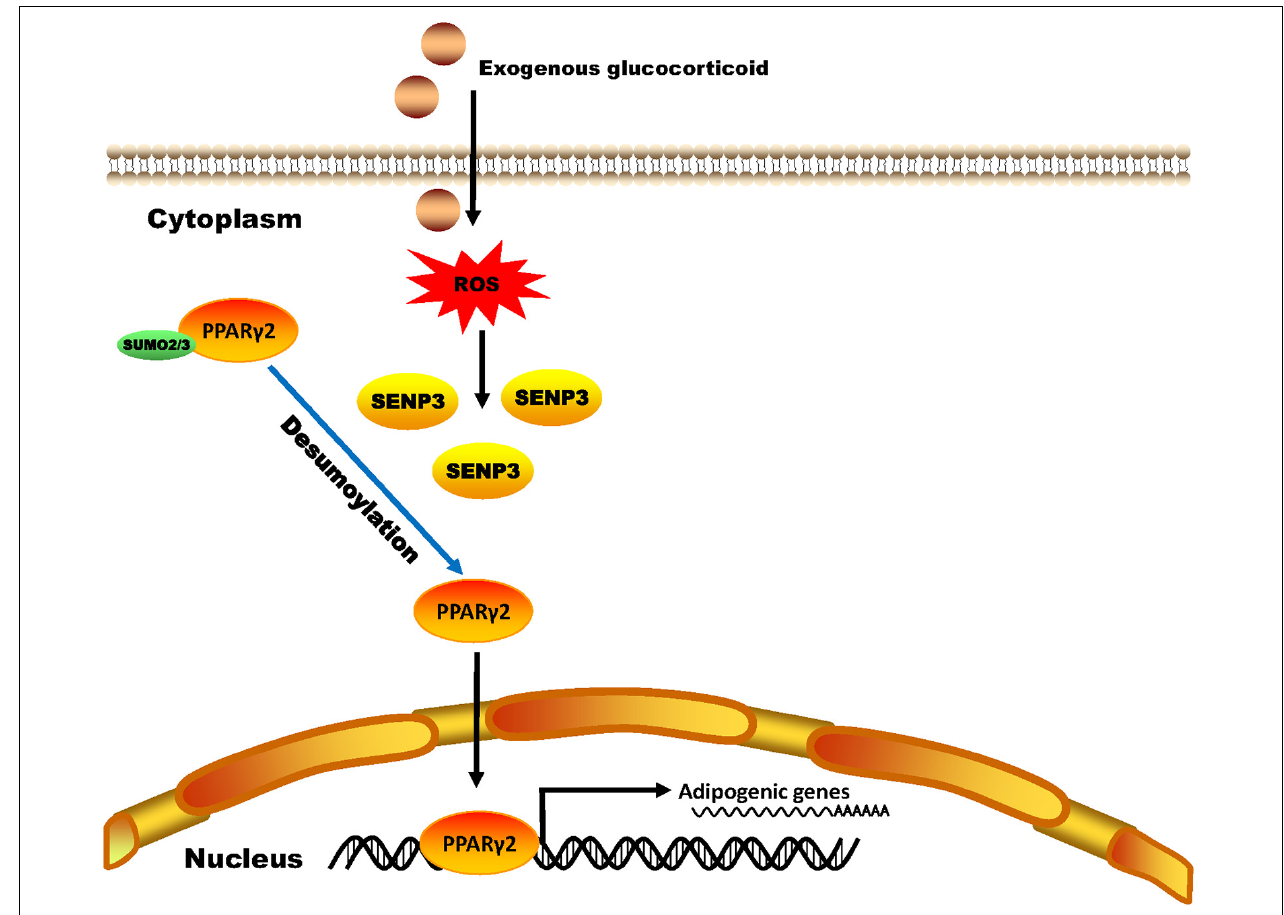
FIGURE 7 | A schematic model of SENP3 function in glucocorticoid-induced PPAR γ 2 signaling. Exogenous glucocorticoid increases the cellular ROS level of BM-MSCs and the protein level of SENP3. SENP3 deSUMOylates SUMO2/3 modification of PPAR γ 2 on Lys residue 107 site and enhanced its activity to promote the expression of adipogenic marker genes such as C/EBP α , adiponectin and FABP4. Therefore, SENP3 potentiates adipogenesis in BM-MSCs and aggravate glucocorticoid-induced osteoporosis under oxidative